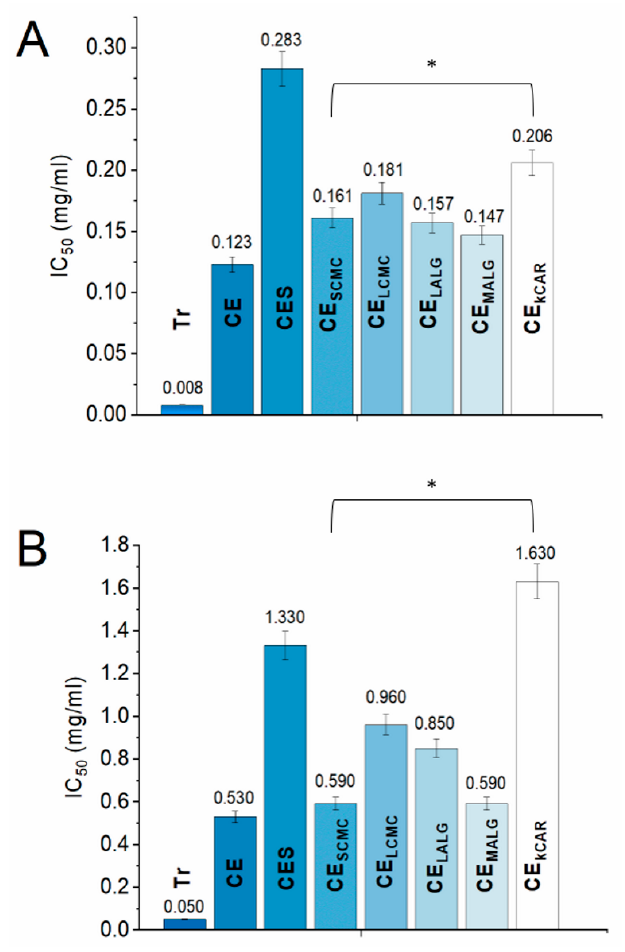
Figure 3. Comparison of the IC 50 values of Trolox (Tr), cranberry extract inside the particles (CE), cranberry extract outside the particles (CES), and CE stored in the polysaccharide microparticles determined using the DPPH ( A ) and ABTS + ( B ) assays. For both assays, the results are presented as the means ± S.D. * Statistically significant at p ≤ 0.05.